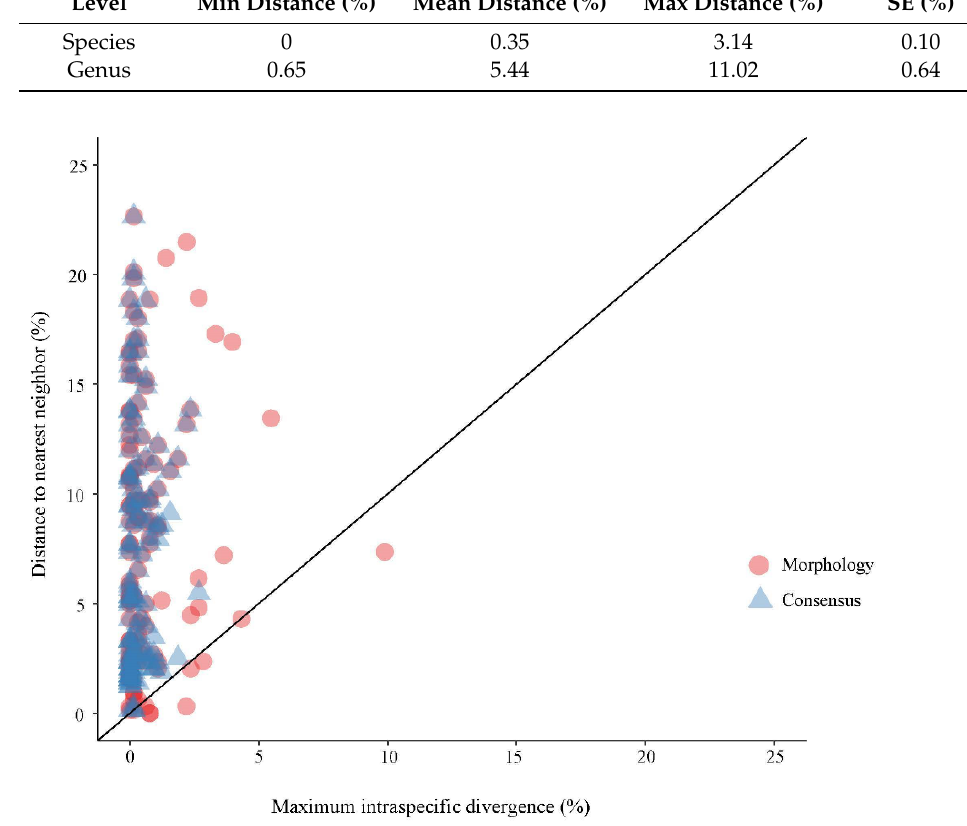
Figure 2. The barcoding gaps for 134 species and 140 OTUs of Guizhou were plotted between maximum intraspecies and nearest-neighbor K2P genetic distances. Species fall above the 1:1 line, indicating the presence of a barcode gap.